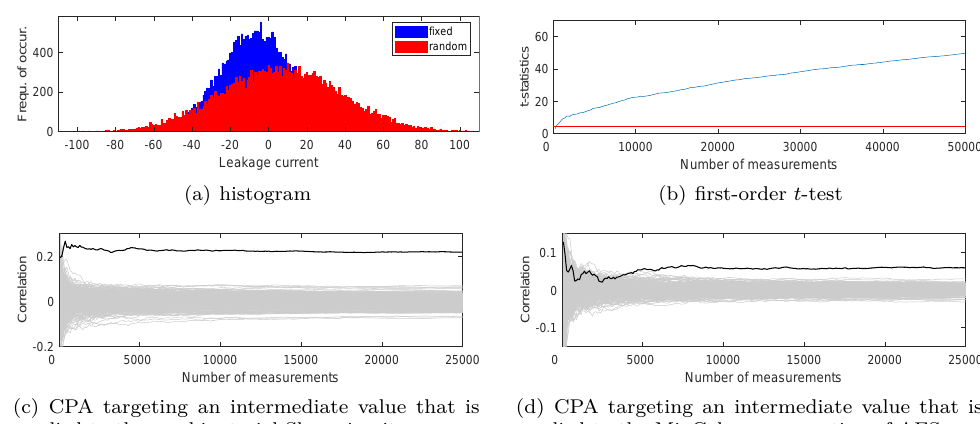
Figure 7: Leakage evaluation and attack using 50,000 fixed vs. random measurements of a byte-serial implementation of AES-128 in 65 nm CMOS technology, recorded at 90 ◦ C and 1 . 6